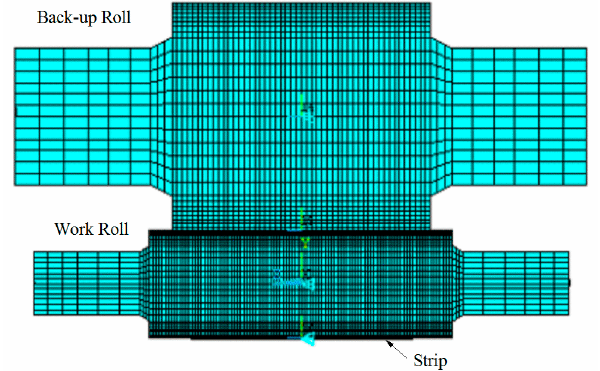
Figure 9. Finite element model of roll ‐ strip coupling.